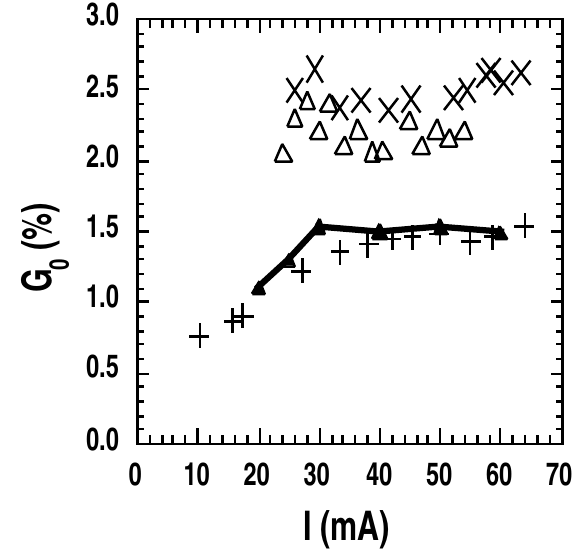
FIG. 3. Initial gain G versus current. Experimental data (+) 0 and related ( (cid:3) ) numerical results computed by the STOK-2D (cid:1) 0 kV . Experimental data ( 4 ) and ( (cid:6) ) for V code for V h (cid:1) 120 kV , 90 kV and V h